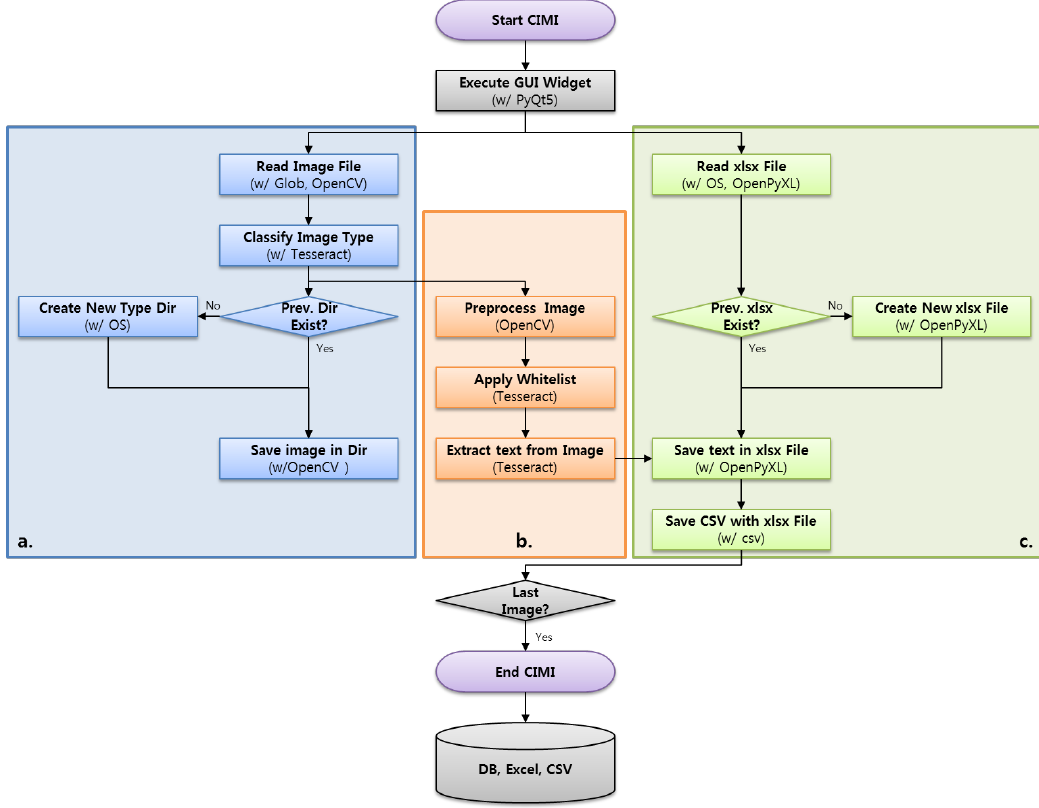
Figure 1. Flowchart of the overall classification and itemization medical image (CIMI) system; ( a ) PFT sheet classification systems; ( b ) PFT sheet preprocessing and PFT text extraction system; ( c ) PFT excel generation system.